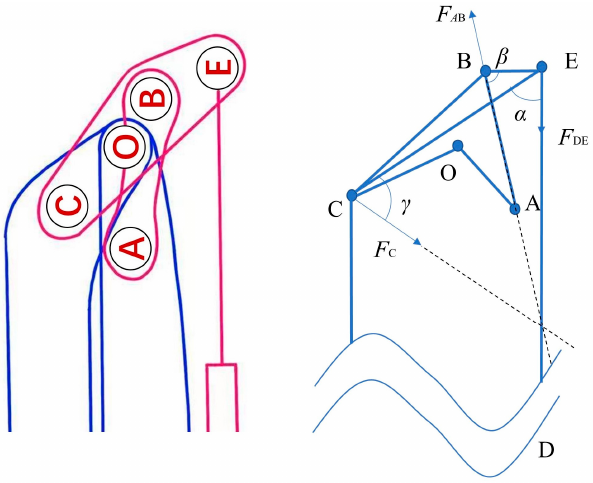
Figure 4. Schematic of cylinder #4 and its linkage mechanism.